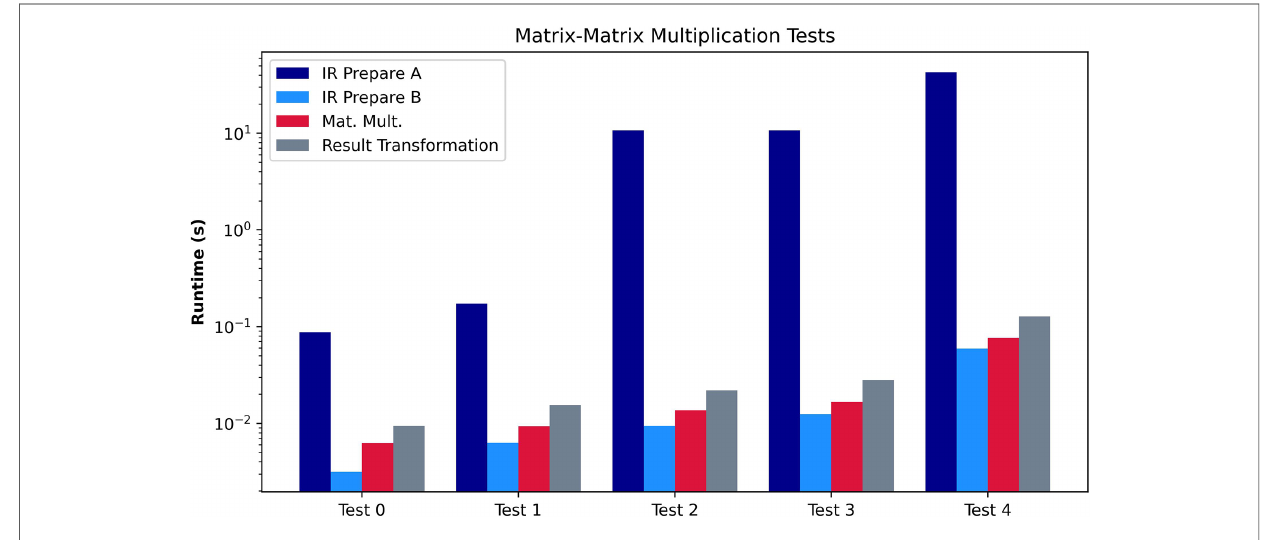
FIGURE 6 Performance evaluation of Algorithm 8 . The graph compares the preprocessing algorithms, Prepare A and Prepare B, in absolute terms, including other